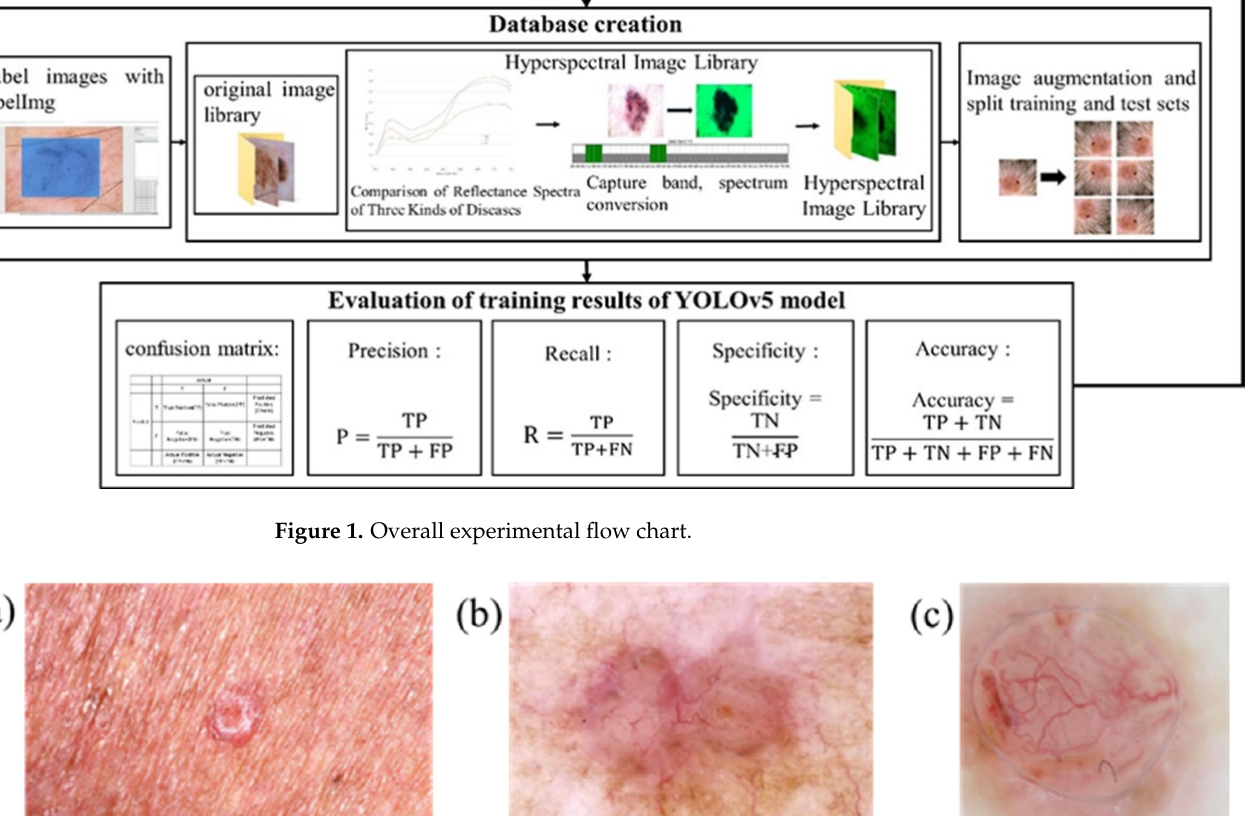
Figure 2. Basal cell carcinoma: ( a ) bright protrusions around the epidermis and ( b , c ) enlarged and frequently hemorrhagic lesions.